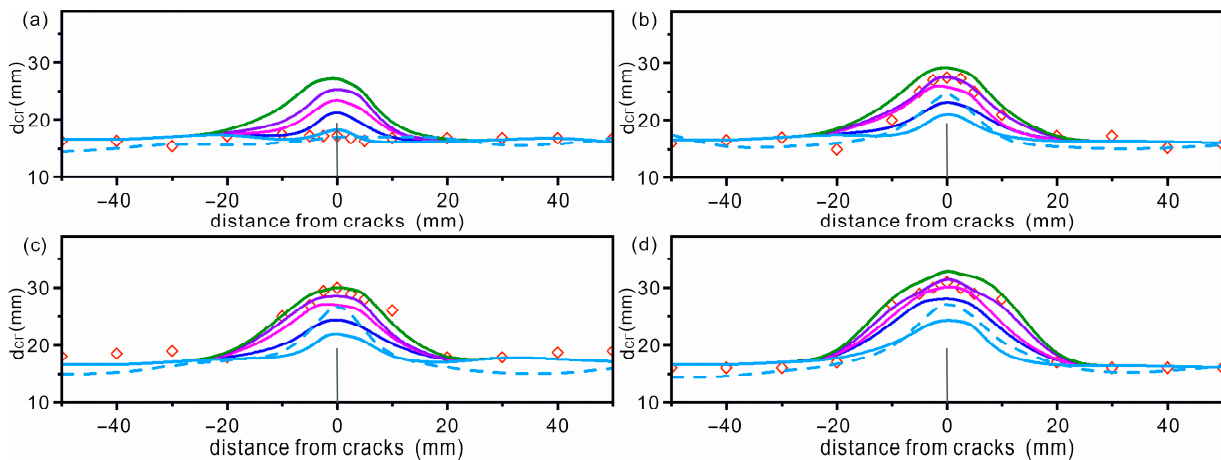
Figure 2. The diffusion depth (d Cl − ) of chloride in concrete with AC widths of ( a ) 50 µ m, ( b ) 80 µ m, ( c ) 100 µ m and ( d ) 200 µ m, respectively. The center of the AC is set to 0. The DZ regions are described by a pair of numbers. Light blue, blue, pink, purple and green represent a diffusion of chloride in concrete with DZs of (0, 0), (5, 5), (10, 10), (15, 15) and (20, 20), respectively. The diamonds and dash lines represent the experimental and simulation results of [14] (reproduced with permission from [14], copyright 2016 Elsevier).